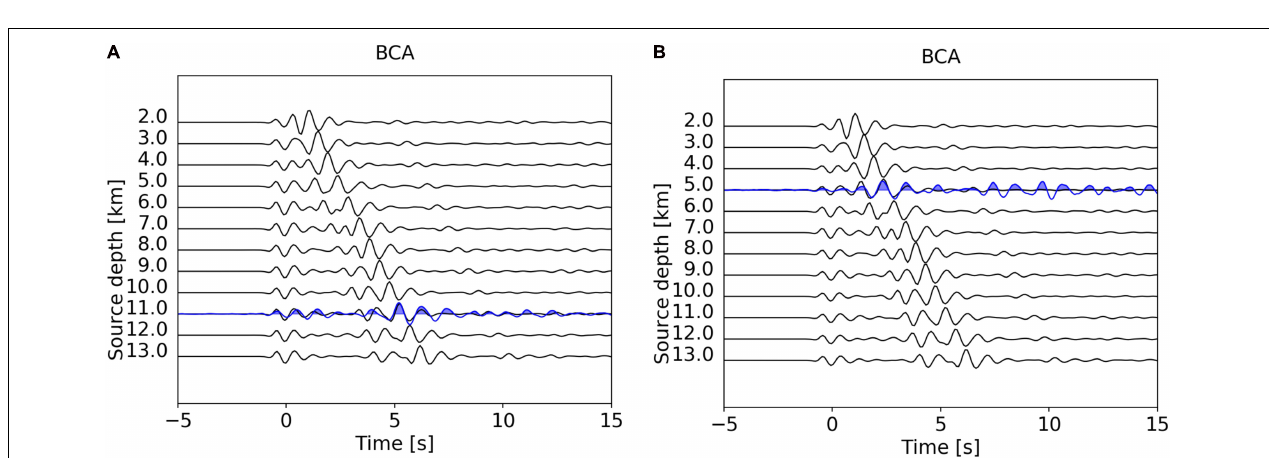
FIGURE 7 | Aftershocks of March 2, 2017, M w 5.5 earthquake: (A) Spatial distribution of the first ten-day aftershocks, which were directly triggered by the mainshock according to the declustering method (green points), and all aftershocks occurred within the first day (blue points). The epicenter of the mainshock is marked by the star. (B) Rose diagram of the directions of the same events relative to the mainshock location, where the preferred strike value of the mainshock focal mechanism is marked as a dashed black line.